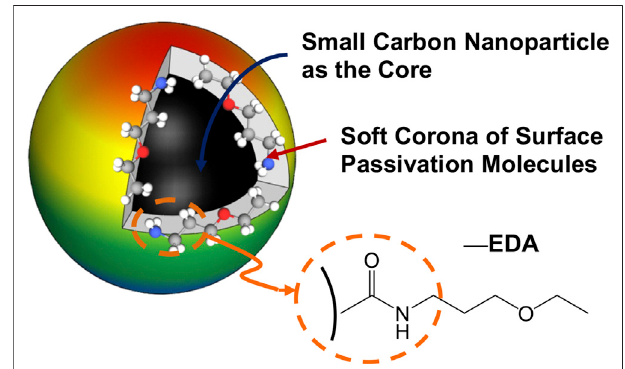
FIGURE 1 | A cartoon illustration of an EDA-CDot, which is generally a small CNP core with attached and strongly adsorbed surface passivation molecules (a con fi guration similar to a soft